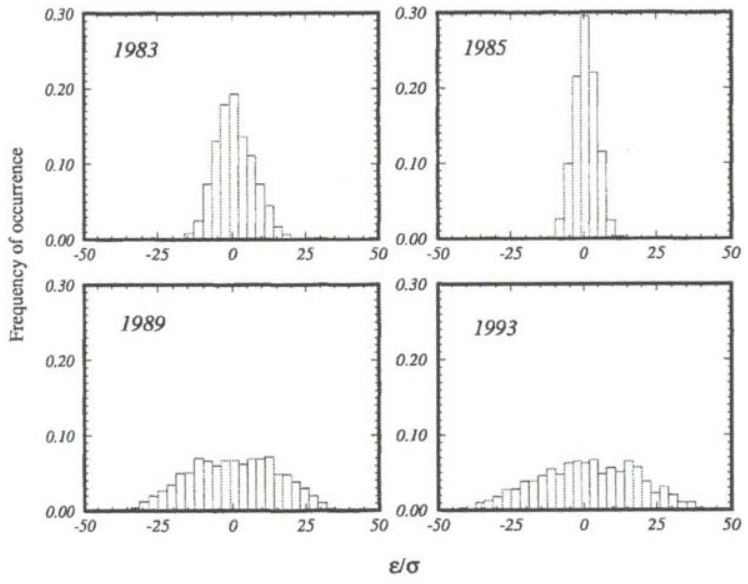
Fig. 5. Distributions of the values of e/σ of four error/sigma tests for the values of σ a calculated from